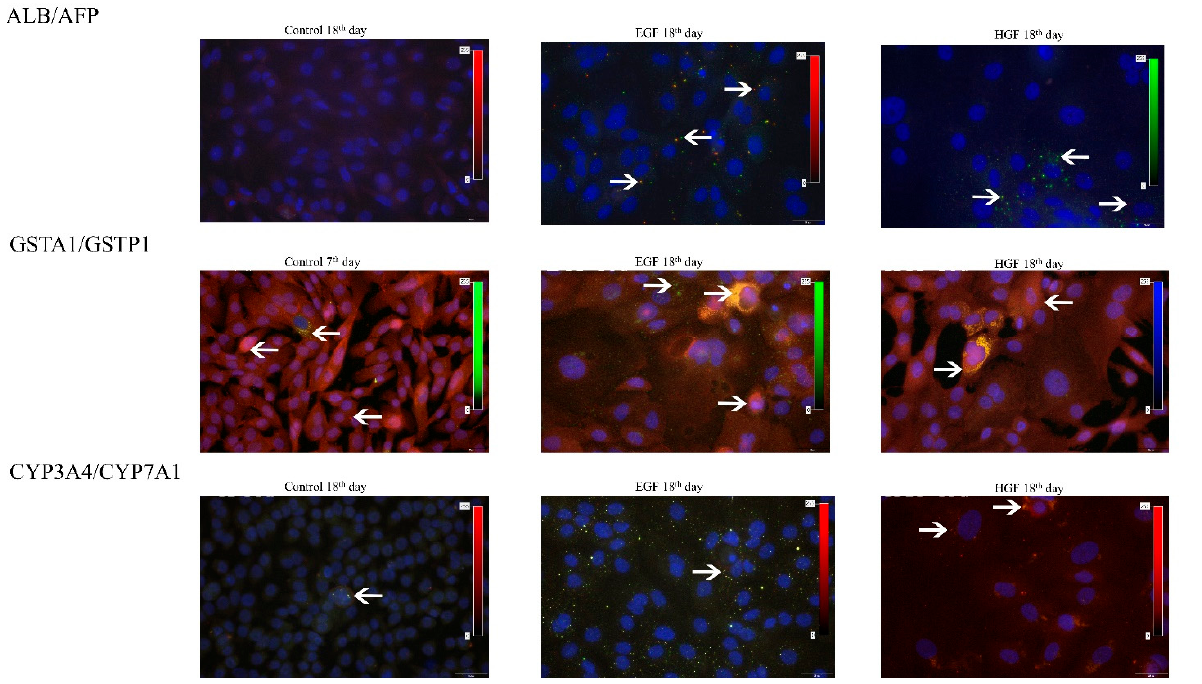
Figure 6. Co-expression of hepatic, hepatoblastic and cholangiocytic markers visualised immunohistochemically at 7 or 18 days of differentiation. Green colour—AFP, CYP7A1, GSTP1, CK7. Red colour—ALB, CYP3A4, GSTA1. Yellow/orange—double-positive cells. The arrows indicate examples of positively stained cells. Magnification 400×.